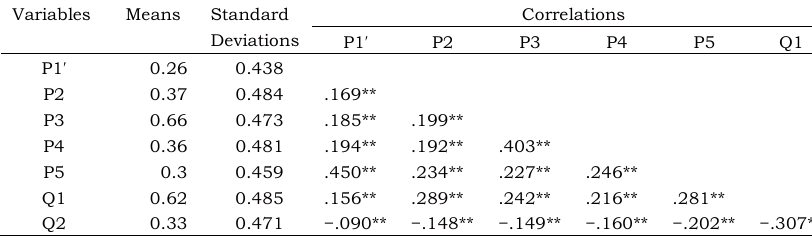
Table 2. Means, standard deviations, and correlations of questionnaire C